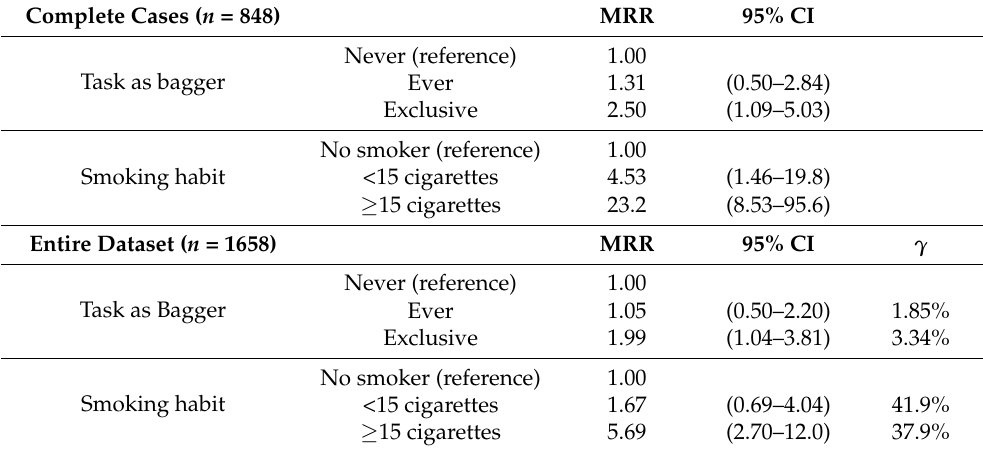
Table 3. Adjusted * multivariate mortality rate ratios (MRR) for lung cancer estimated by Poisson regression and 95% confidence intervals (95% CI) for the complete cases and for the imputed datasets. The value of γ represents the fraction of information missing due to